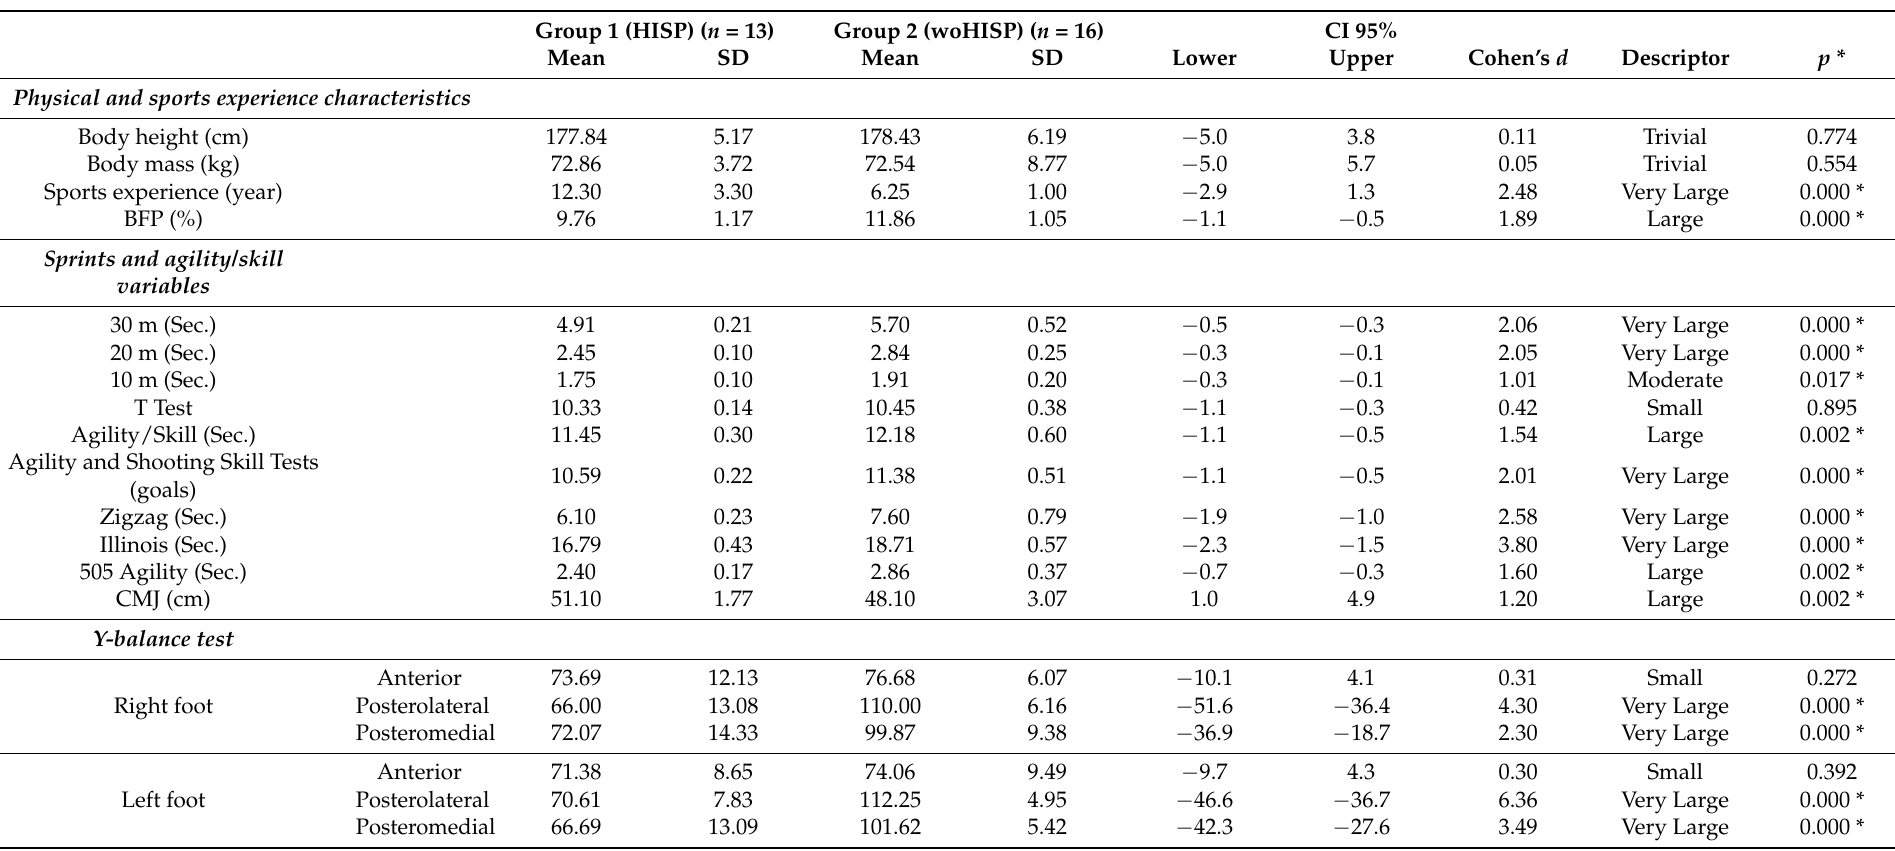
Table 1. Measurement results in soccer HISP groups and woHISP